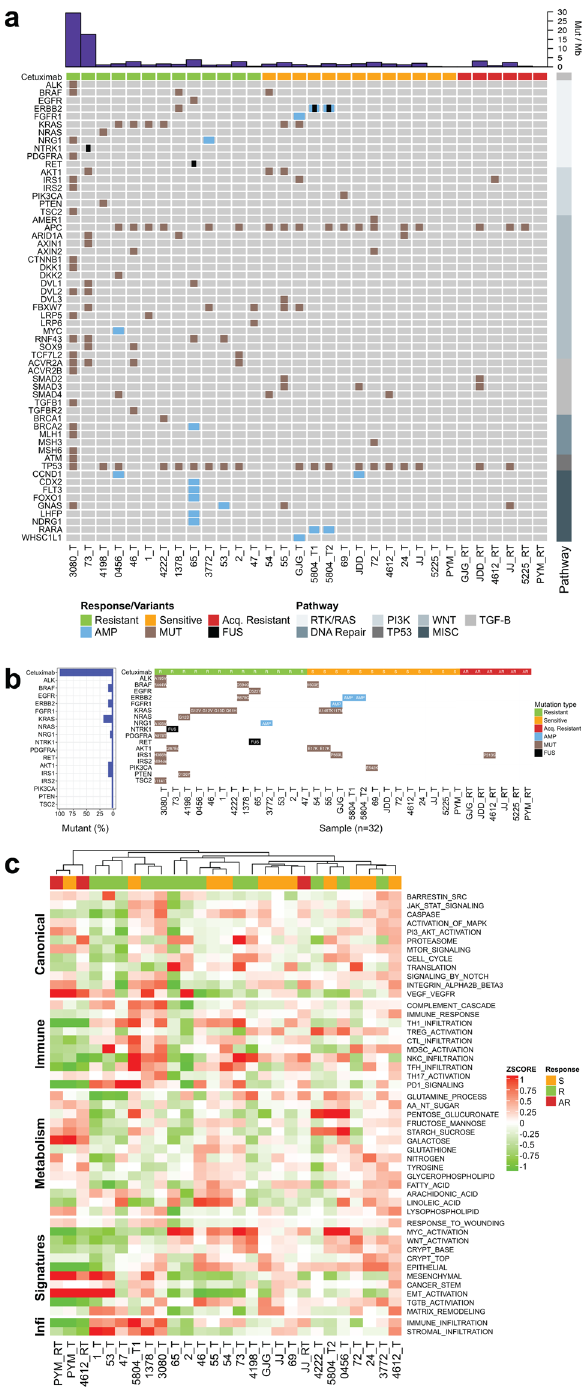
Figure 2. Landscape of somatic variants and gene set expression signatures in sensitive, resistant, and acquired- resistant tumours. ( a,b ) Somatic variants identified in genes grouped by molecular pathways. MUT, non- synonymous single nucleotide or small indel mutation; FUS, gene fusion; AMP, copy number amplification (CN ≥ 4). The top bar chart shows the tumour mutation burden of non-synonymous somatic variants. Amino acid change is shown for a subset of genes in ( b ). ( c ) Hierarchical clustering of gene set expression signatures for a panel of published molecular signatures (see Methods). The Z score represents both the magnitude and relative direction of a signature’s expression. Baseline tumour (T), acquired-resistant tumour